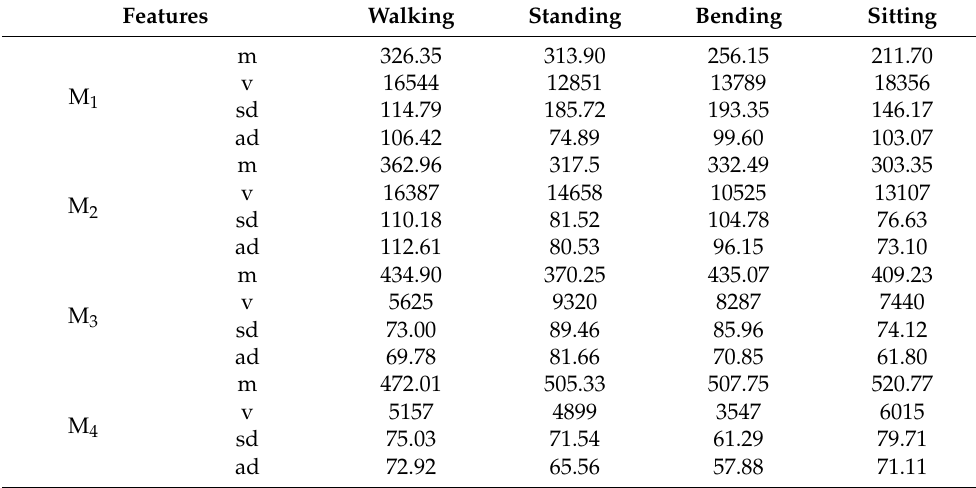
Table 2. Feature values